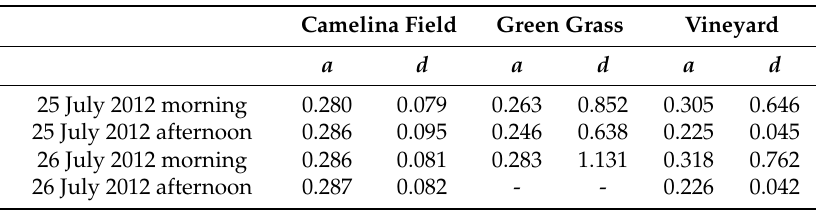
Table 2. Values of parameters a and d obtained from the fit of the field broadband albedos to the parameterization as a function of the solar zenith angle.